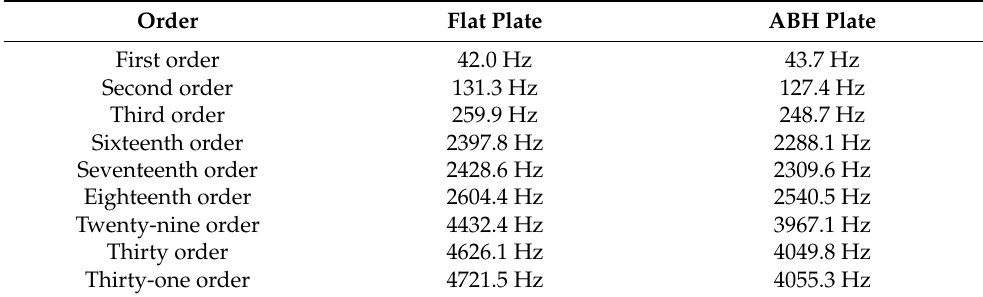
Table 3. Comparison of characteristic frequencies of flat plates and ABH